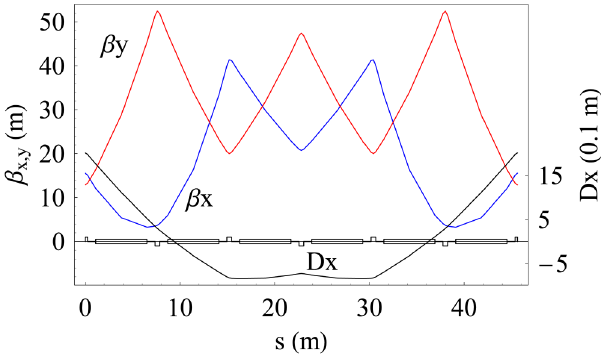
FIG. 1. (Color) Twiss parameters for the quasi-isochronous